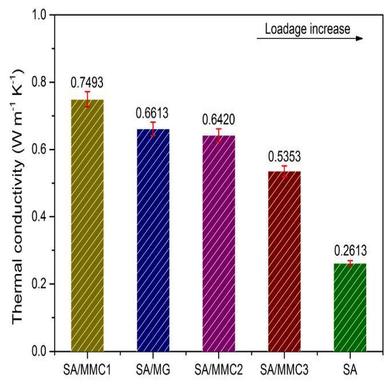
Thermal conductivity of SA, SA/MG, and SA/MMCs. (Testing repetition times is 3).